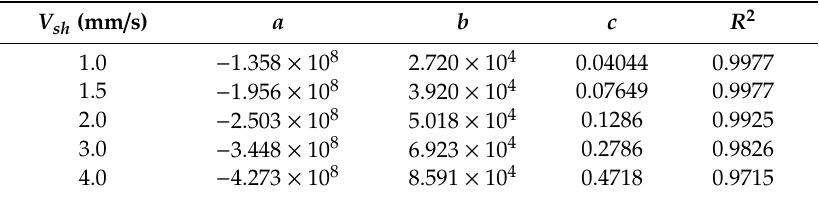
Figure 4. Flow velocity V as a function of x for five sheath flow velocities V sh at the sample flow velocity V sa of 1.8 mm / s. Table 3. The fitted coe ffi cients of flow velocity V versus x at five demonstrative sheath flow velocities V sh at the sample flow velocity V sa of 1.8 mm/s .